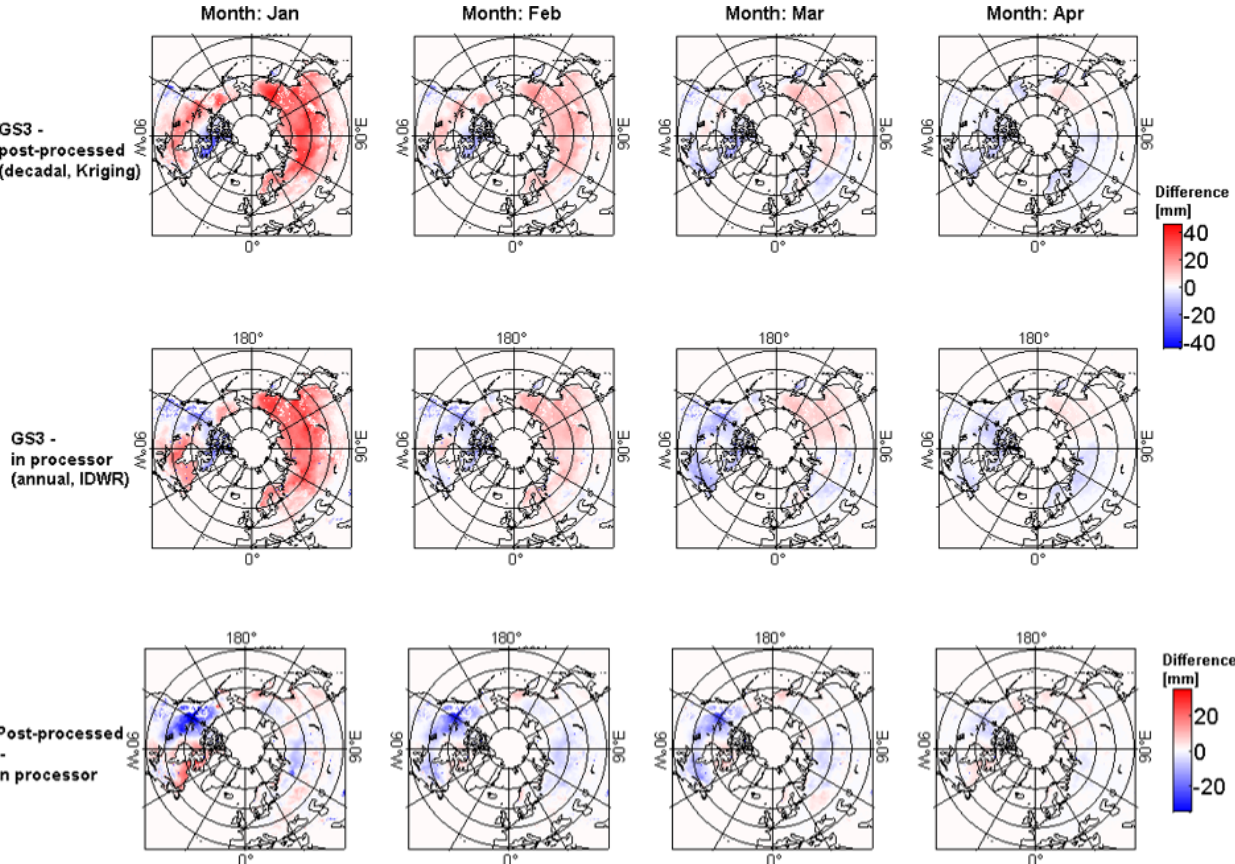
Figure 10. Top row shows the average monthly difference in SWE between the GSv3.0 product and post-processed product (decadal, Kriging). The middle row shows the average monthly difference between the GSv3.0 product and product with IDWR densities inside the processor. The bottom row shows the average monthly difference between the post-processed product and product with IDWR densities in the processor. Note the differing scales in the monthly (left) and annual (right) plots. Monthly averages are calculated for the years